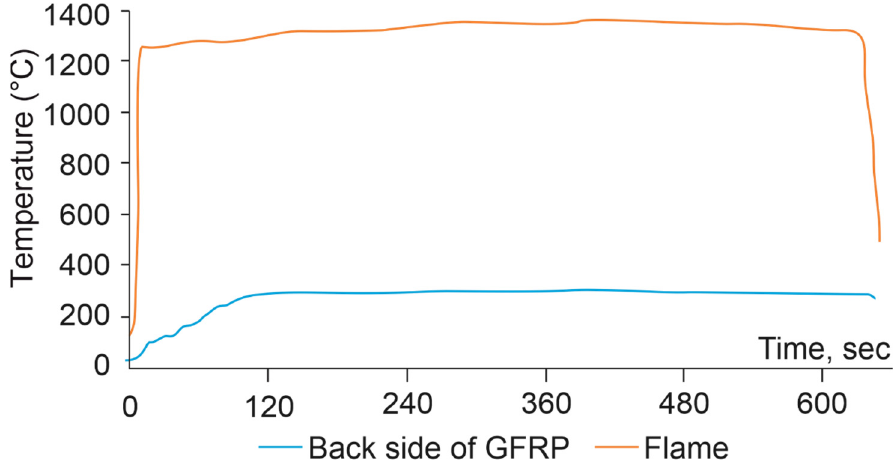
Figure 11. Dependence of the temperature of the back side of the GFRP during burning for 10 min at ~1300 °C. at ~1300 ◦